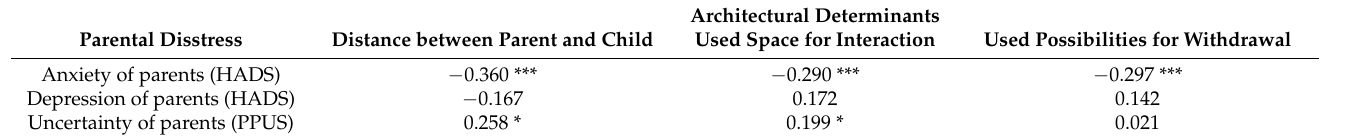
Table 3. Correlations of parental stress and architectural determinants of the patient room.